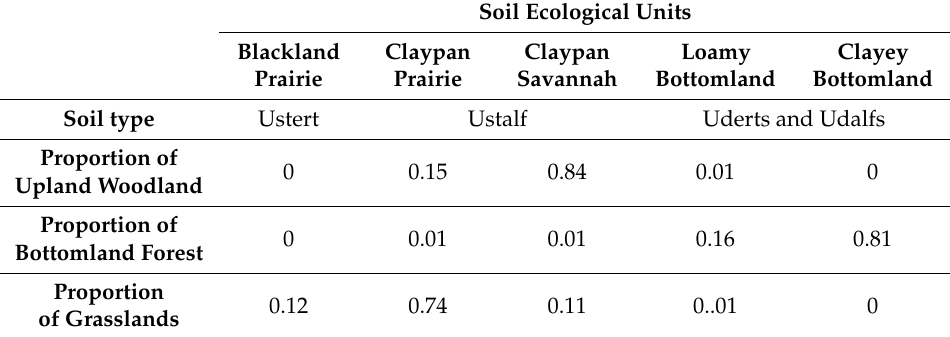
Table 4. The proportions of Upland Woodland, Bottomland Forest and Grassland in each soil-ecological unit determined by overlaying the map of reconstructed vegetation types (Figure 1) onto the soil-ecological units mapped in Brazos County by Natural Resources Conservation Service, US Dept. of